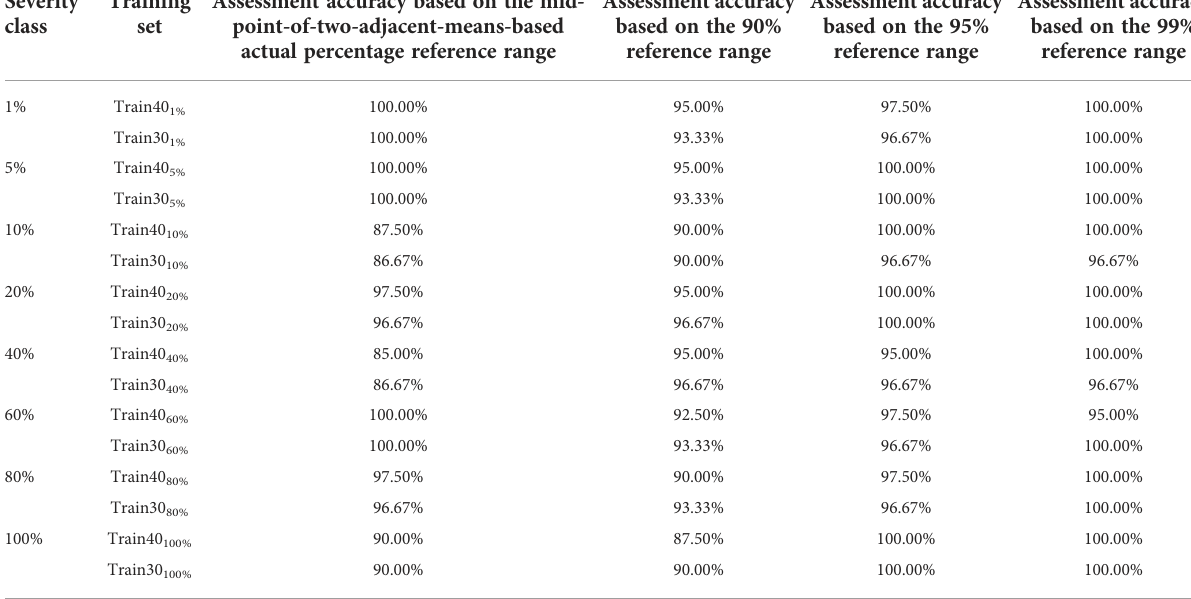
TABLE 4 Severity assessment results of the diseased wheat leaves with the actual percentages of lesion areas contained in each training set of all the severity classes of wheat stripe rust according to the determined reference